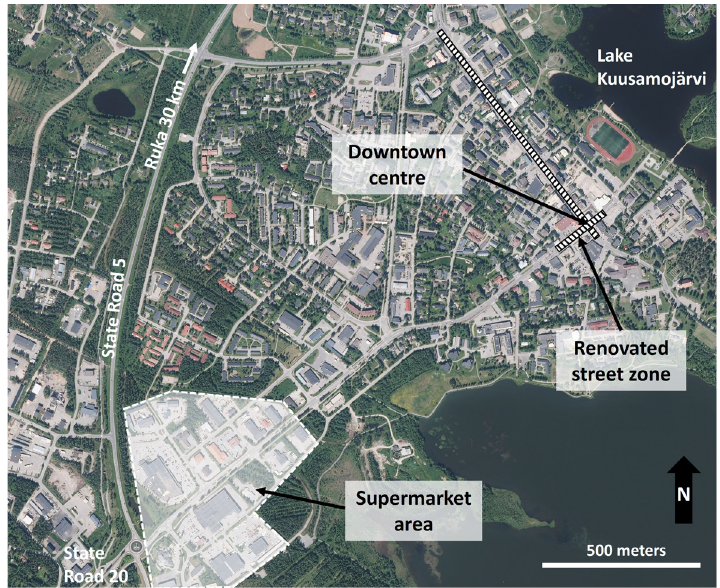
Fig. 4. ‘Dual centre’ of Kuusamo (Background: Maanmittauslaitos Ortokuva